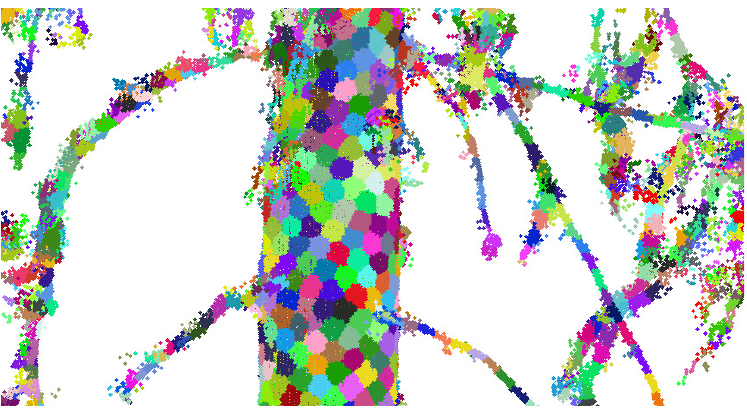
Figure 5. A cover which is a partition. Different colors denote different cover sets.